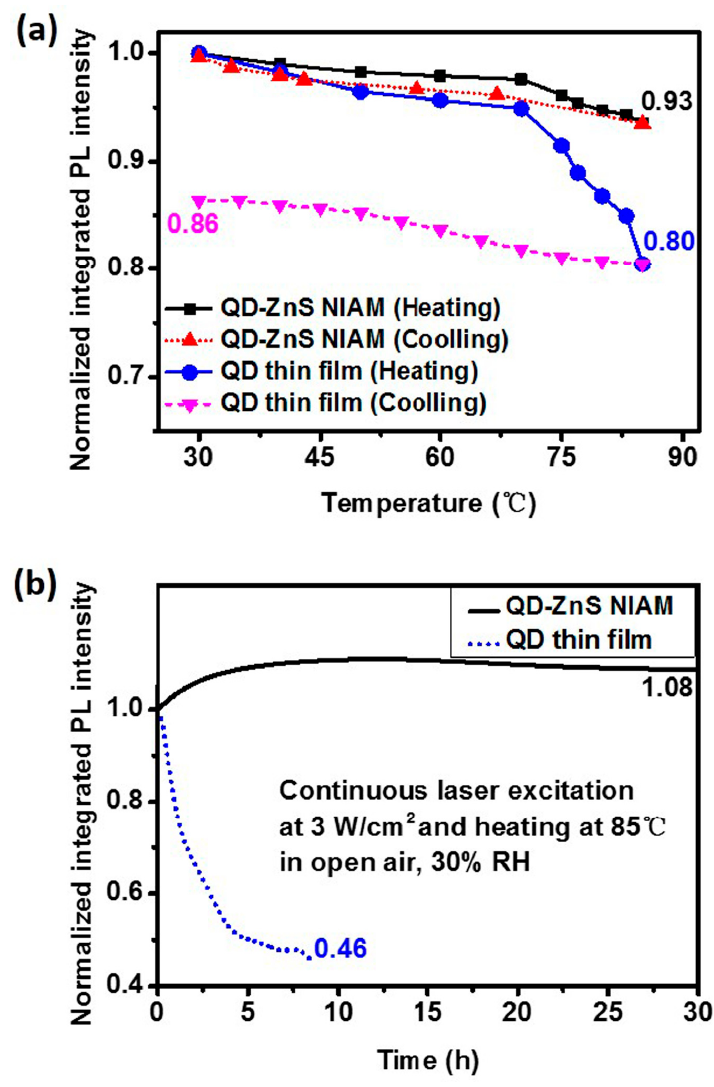
Figure 5. ( a ) The thermal quench and PL reversibility test results of the QD-ZnS NIAM and the QD thin film; ( b ) Photochemical stability test results of the QD-ZnS NIAM and the QD thin film at 85 °C and 30% relative humidity (RH) under continuous laser excitation in air.